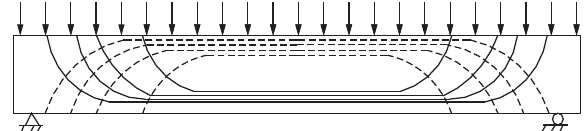
Figure 10: The principal stress trajectory of thin immediate roof under uniform